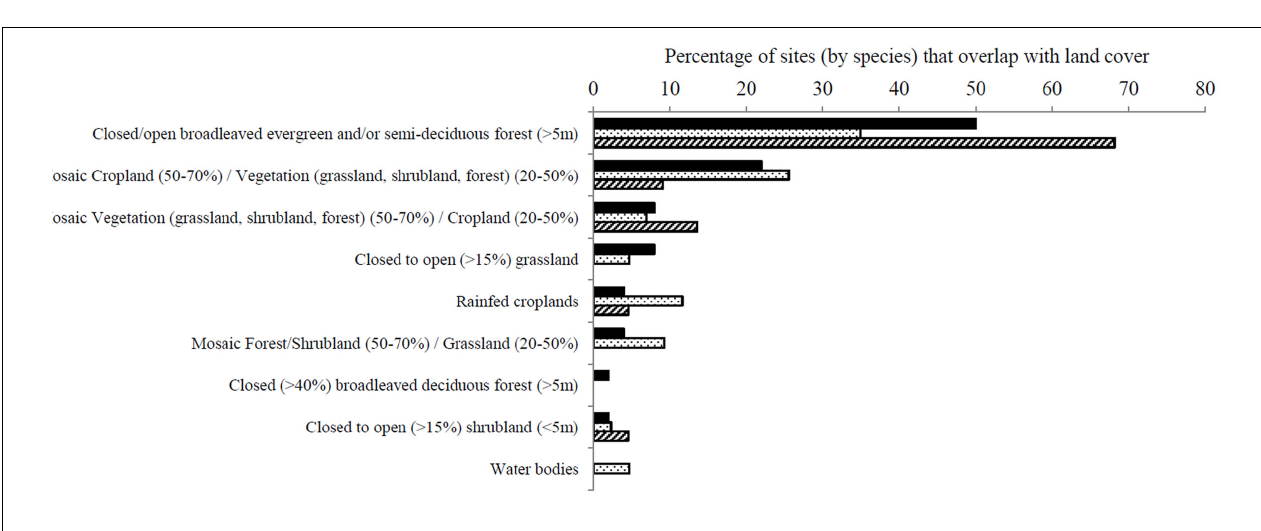
FIGURE 5 | Percentage of collection sites of A. albimanus (black bars), A. pseudopunctipennis (spotted bars), and A. punctimacula (diagonal bars) larvae in Ecuador, categorized by geographic overlap of land cover categories from GlobCover © 2009 MERIS (MEdium Resolution